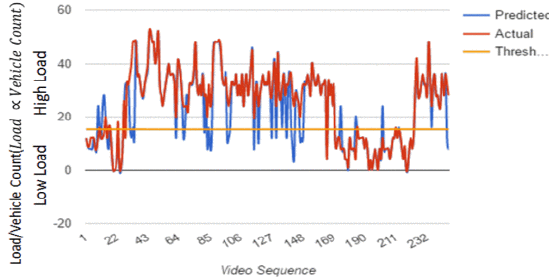
Fig.10. Online Analysis and Visualizations on